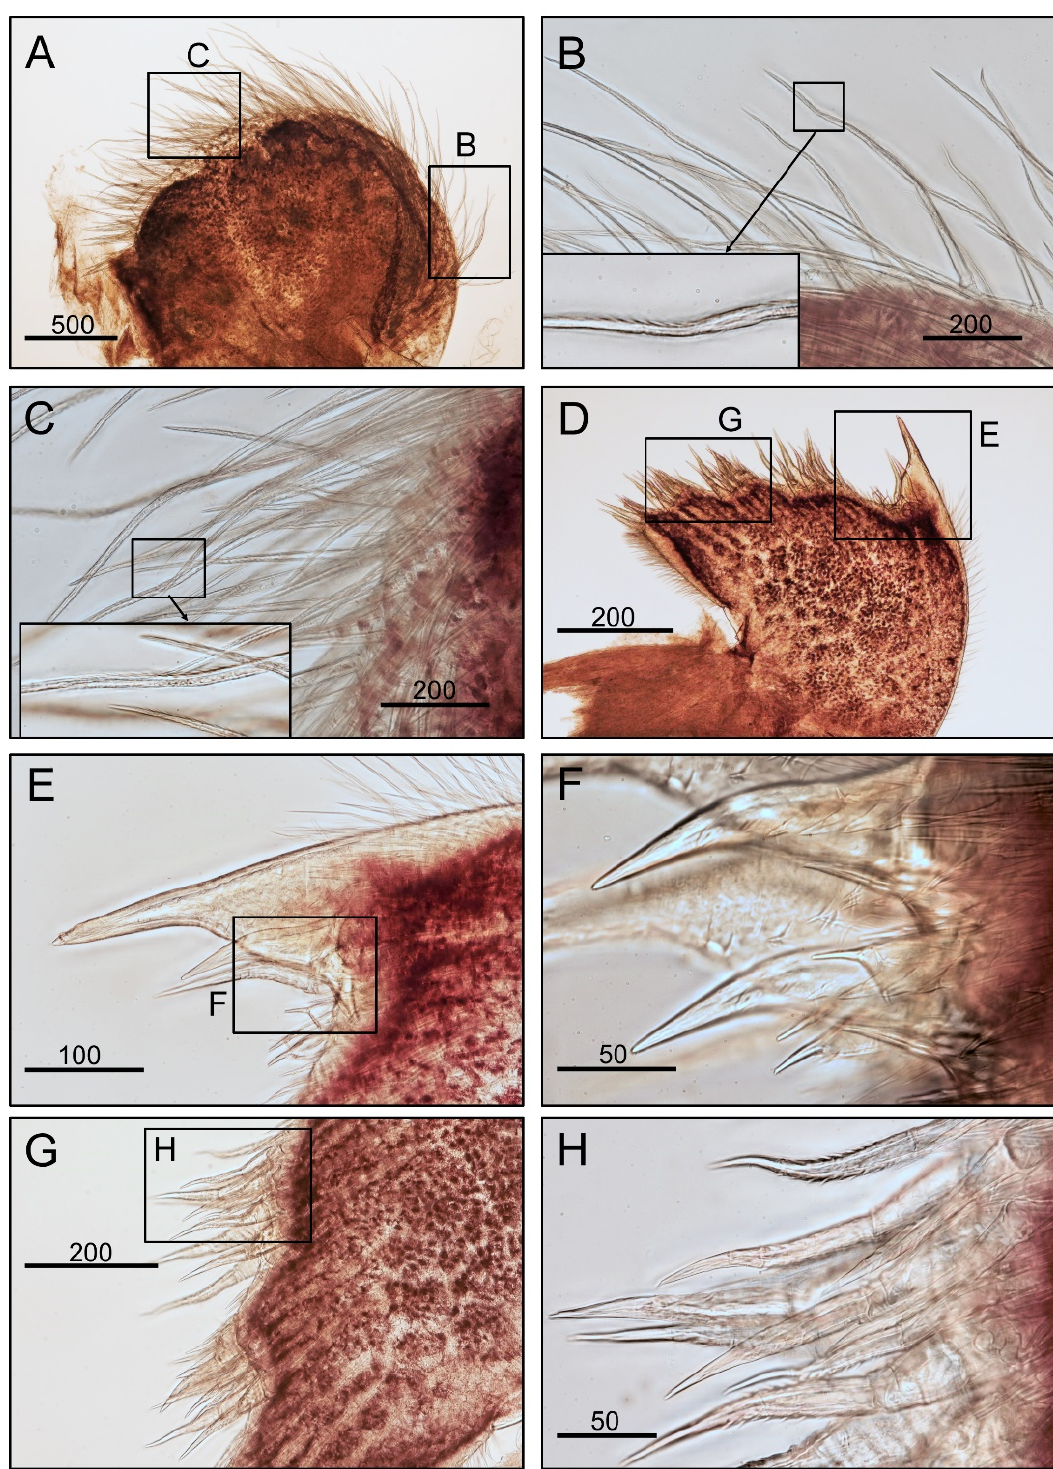
Figure 10. Conchoderma hunteri. ( A ) Maxilla. ( B ) Serrulate setae at outer margin of maxilla. ( C ) Serrulate setae at inner margin of maxilla. ( D ) Maxillule, showing three zig-zag regions at cutting edge. ( E ) Large spine of maxillule. ( F ) Simple setae at the base of large spine of maxillule. ( G ) Cutting edge of maxillule. ( H ) Serrulate-type setae at cutting edge of maxillule. Scale bars in μ m.